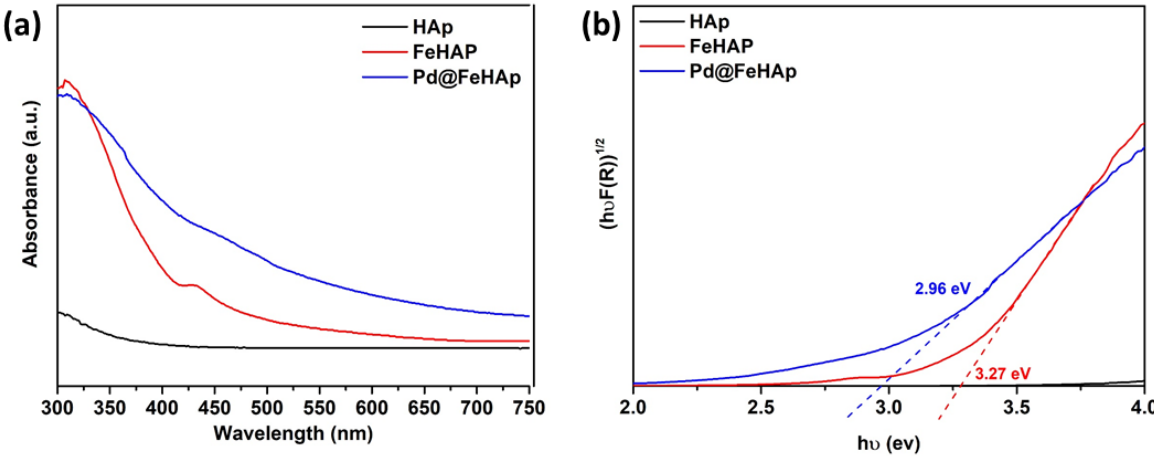
Figure 2. ( a ) UV–Vis DRS spectra and ( b ) energy band gap plots of HAp, FeHAp, and Pd@FeHAp.